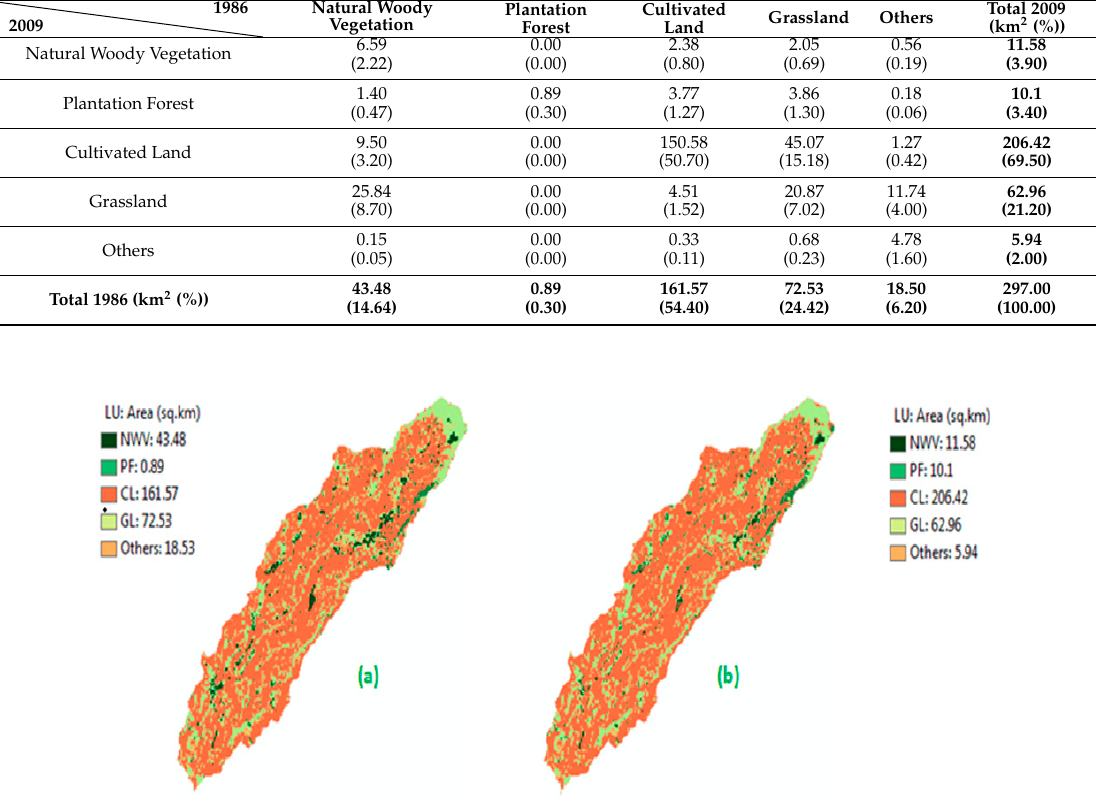
Figure 2. Observed land-use maps of ( a ) 1986 and ( b ) 2009.